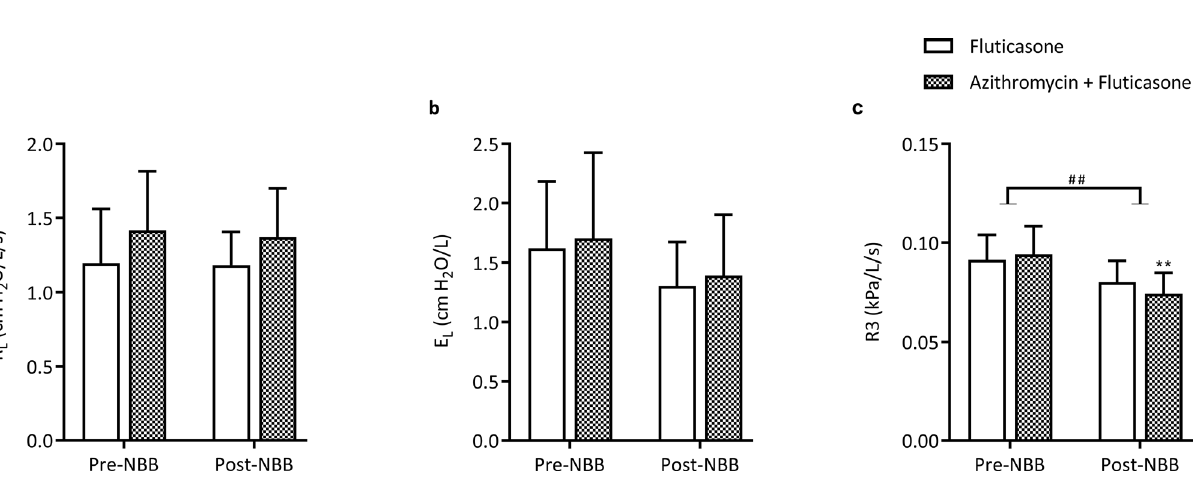
Figure 2. Bronchodilator test. Values of pulmonary resistance (R L ; a ), elastance (E L ; b ) and resistance at 3 Hz (R3; c ) before and after administration of N-butylscopolammonium bromide (NBB) (mean and standard error of the mean). **p < 0.01 compared to pre-NBB with Sidak’s multiple comparison tests and ## p < 0.001 for the main bronchodilator